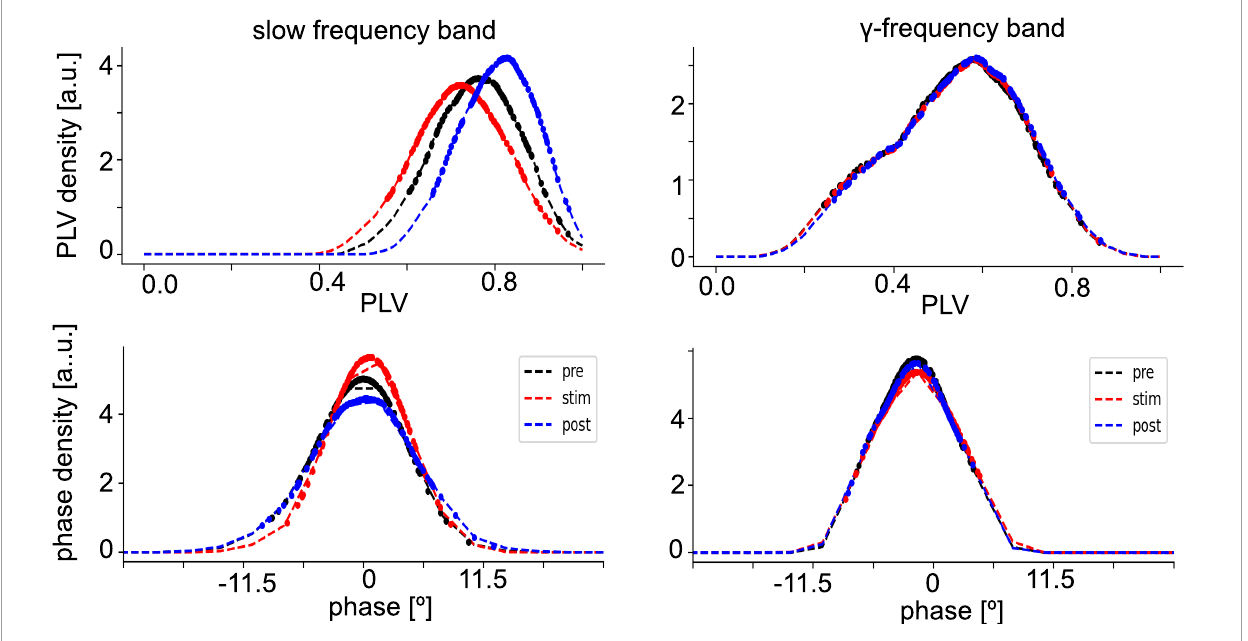
FIGURE4 Distribution of phase synchronization. Phase Locking Value (PLV) density estimates (top panels) and phase difference density estimates (bottom panel) of all electrode pairs (dashed line). Dotted points denote data whose PLV density values is among the highest 80% of densities or have PLV-values larger than the PLVs with maximum density. The data are taken from animal #7 at medium anesthetic levels.